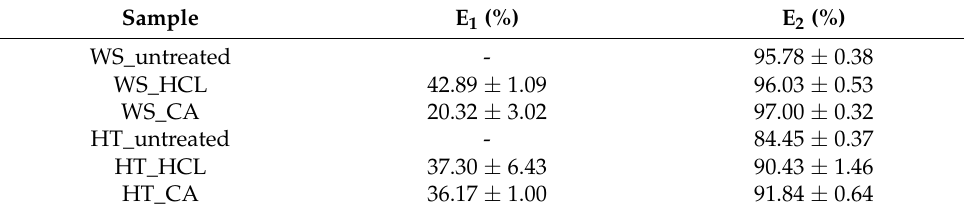
Table 2. Hydrolysis and high-temperature treatment